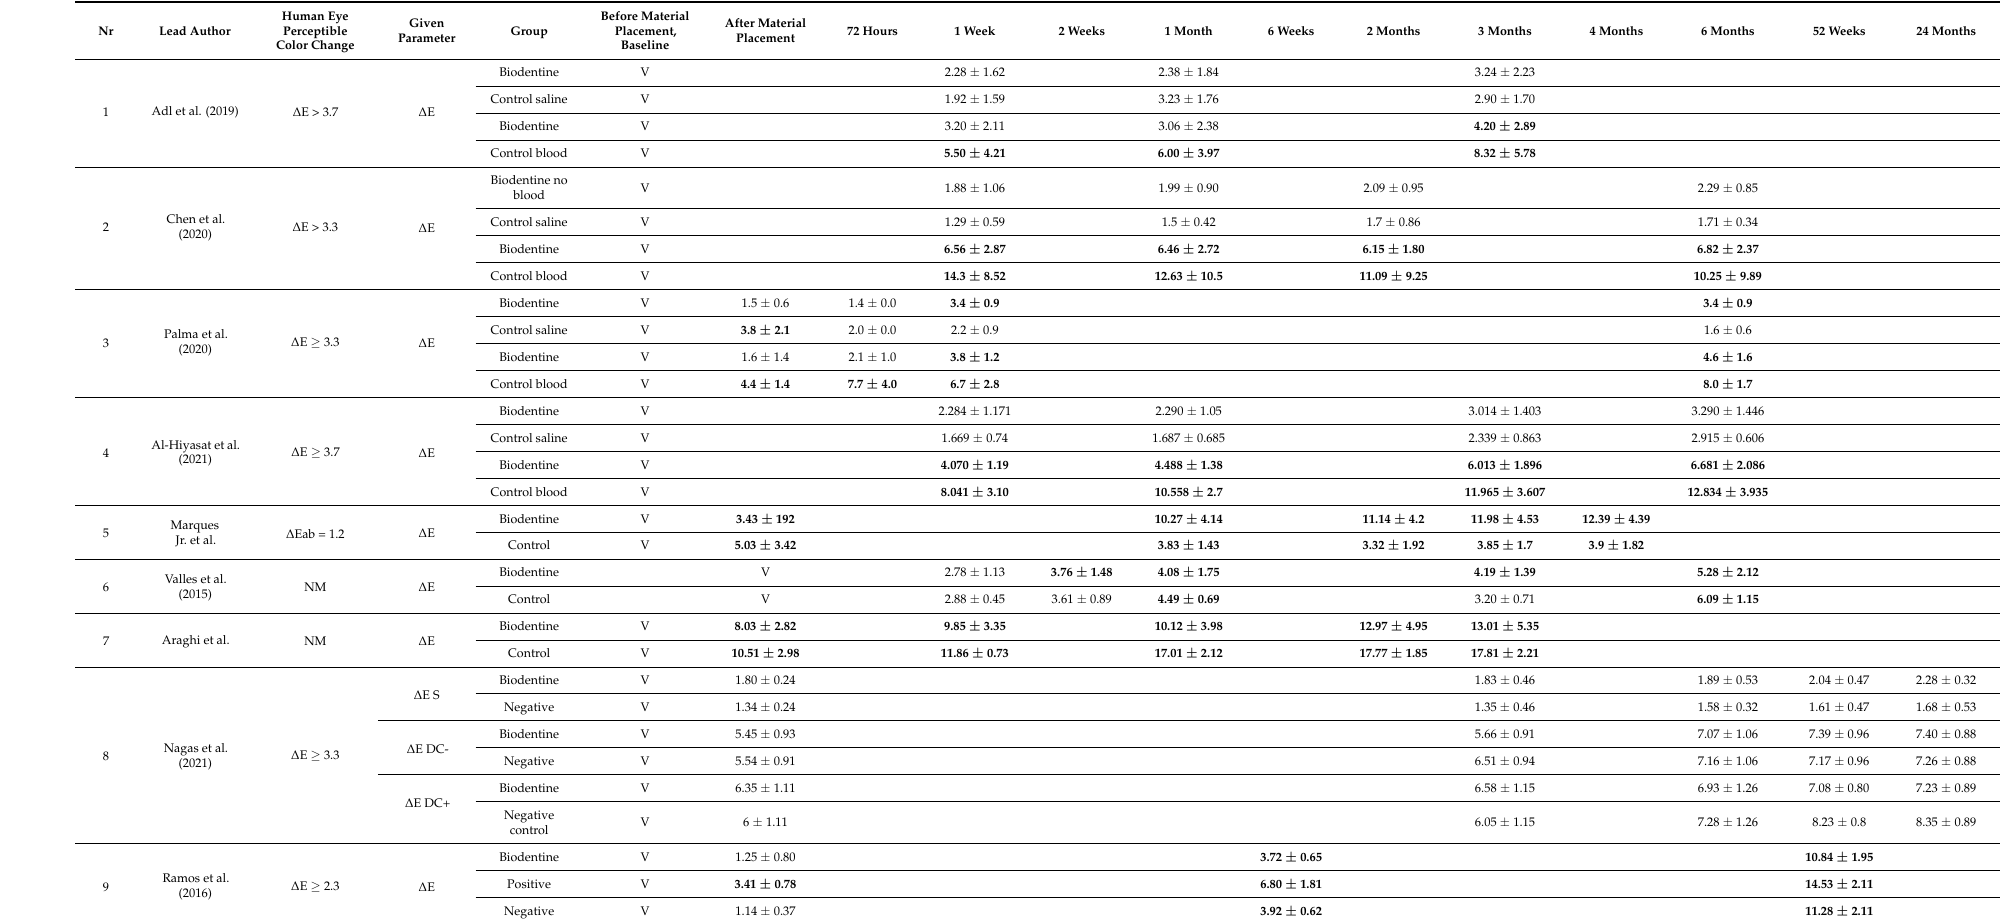
Table 2. The Changes in Color ( ∆ E) Measured for Materials Tested at Different Time